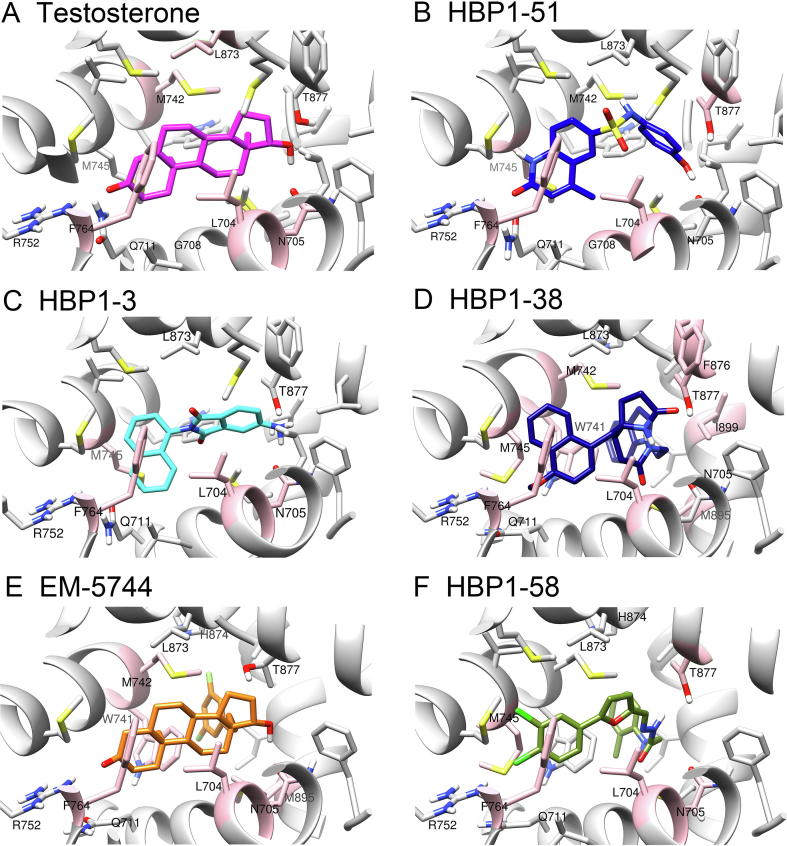
The binding poses of the AR ligands in the AR-LBDThe binding poses of testosterone (A), HBP1-51 (B), HBP1-3 (C), HBP1-38 (D), EM-5744 (E), and HBP1-58 (F) in the binding pocket of AR-LBD were predicted using molecular docking. The binding poses of testosterone and EM-5744 were directly captured from the crystal structures, and poses of the four HBP ligands were generated using the Glide docking. Residues identified by the molecular mechanics/generalized born surface area (MM/GBSA) free energy decomposition were highlighted in pink.